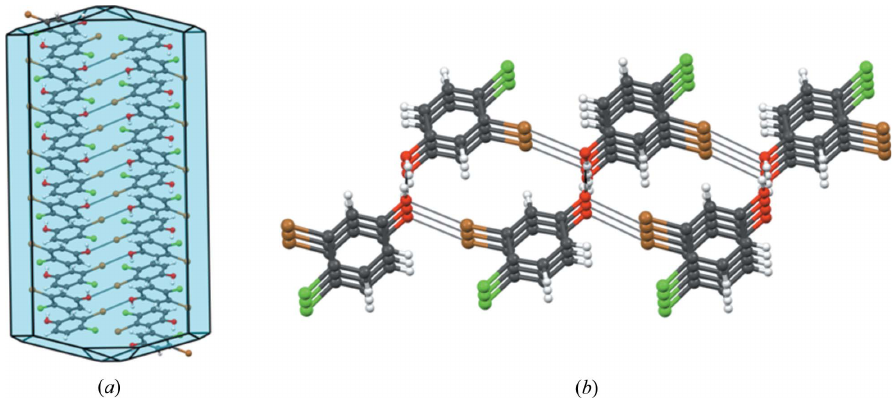
Figure 7 3-Bromo-4-chlorophenol ( 3 ). ( a ) Predicted BFDH morphology; ( b ) strong O—H (cid:2)(cid:2)(cid:2) O and Br (cid:2)(cid:2)(cid:2) O interactions perpendicular to the short